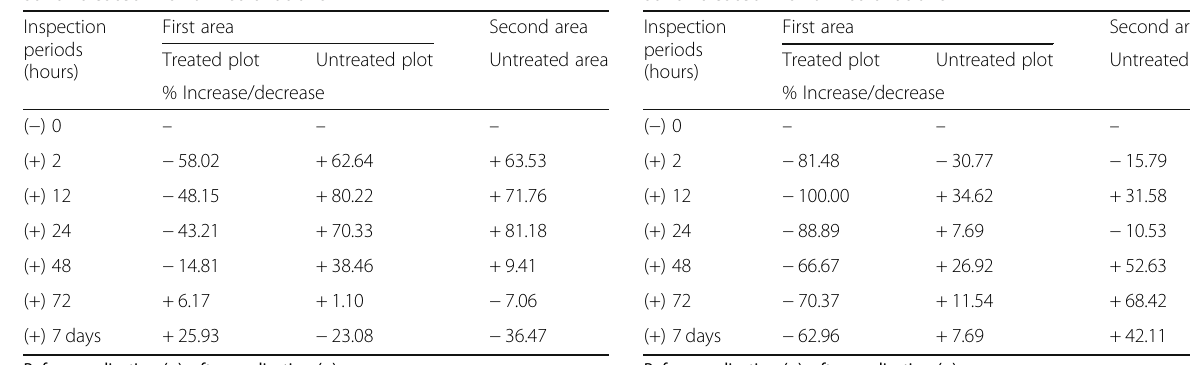
Table 4 Percentage of increase or decrease in